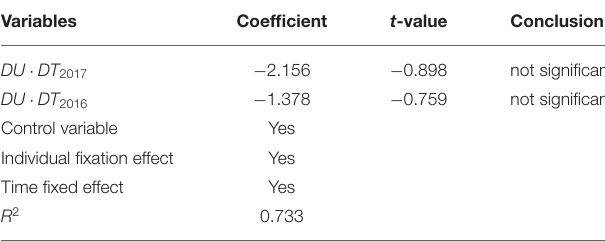
TABLE 5 | Counterfactual